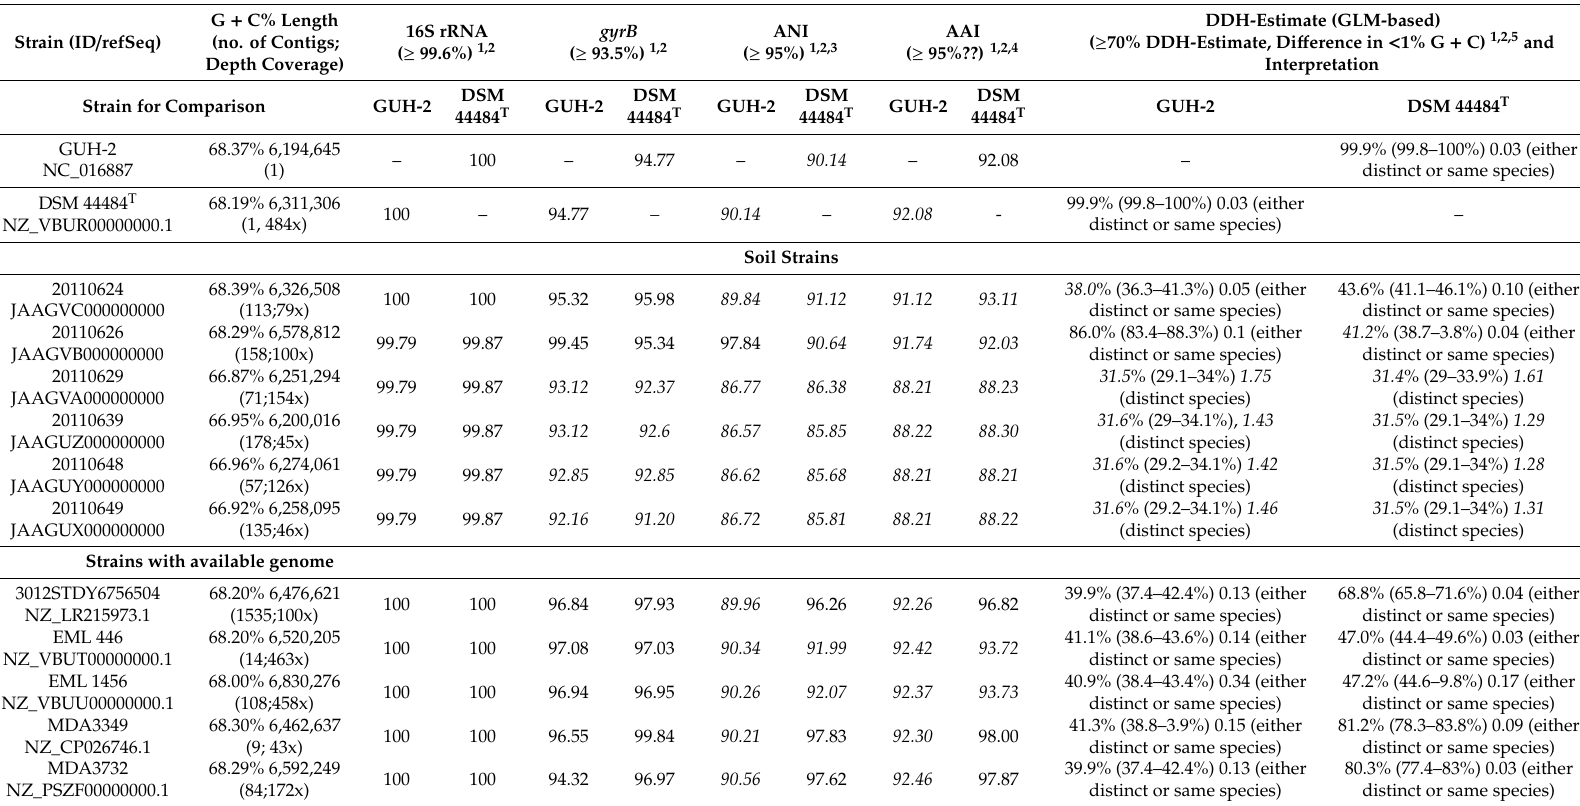
Table 3. Comparison of the whole-genome sequences of the N. cyriacigeorgica soil strains and other stated strains, with respect to the reference genome of N. cyriacigeorgica GUH-2 (NC_016887.1) and the genome of the type strain N. cyriacigeorgica DSM 44484 T . Strain (ID / refSeq)